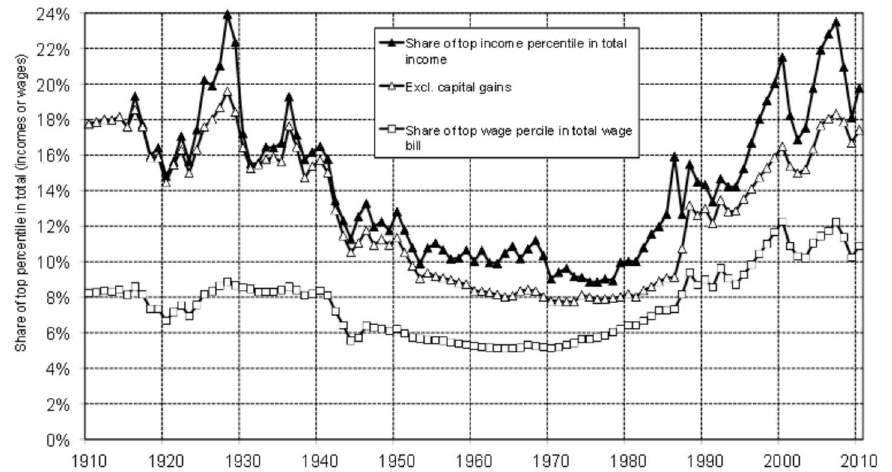
Figure 1. The share of income of the upper percentile in the total income